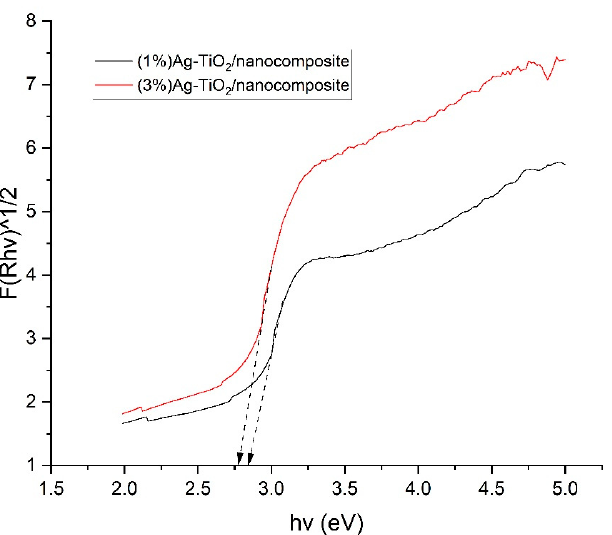
Figure 6. Transformed Kubelka-Munk (from diffuse reflectance spectra) with energy of excitation source for (1%)Ag-TiO 2 /rGO/HNT and (3%)Ag-TiO 2 /rGO/HNT. The band gap energies of the samples decrease in the following order: TiO 2 (3.2 eV) > (1%)Ag-TiO 2 > (3%)Ag-TiO 2 . As a result, the photocatalytic activity for CIP degradation